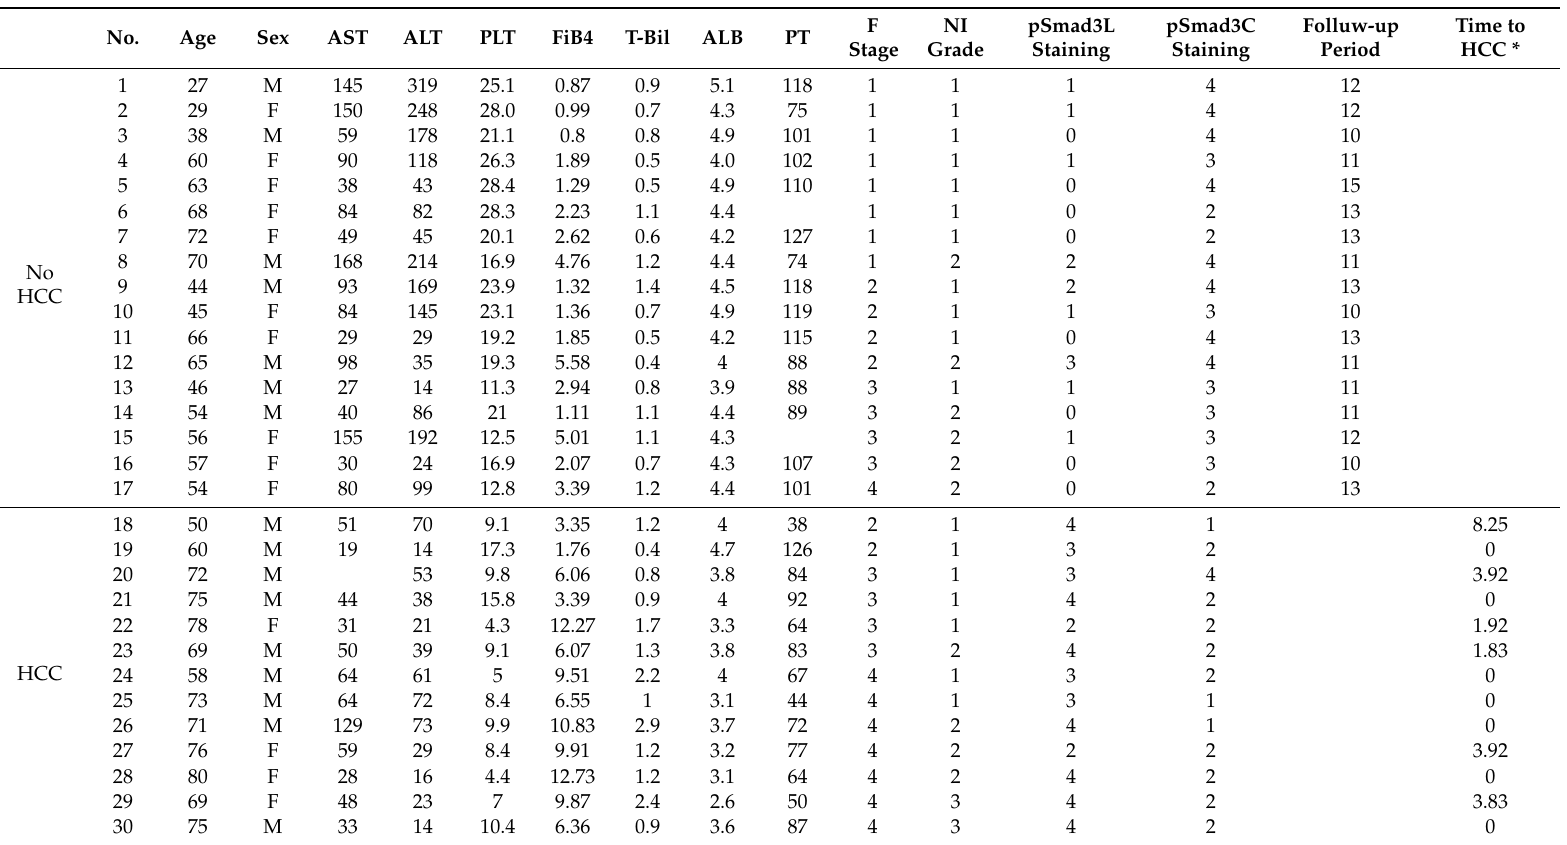
Table 1. Clinicopathologic features and Smad2 / 3 / L / C phosphorylation in liver specimens from patients with